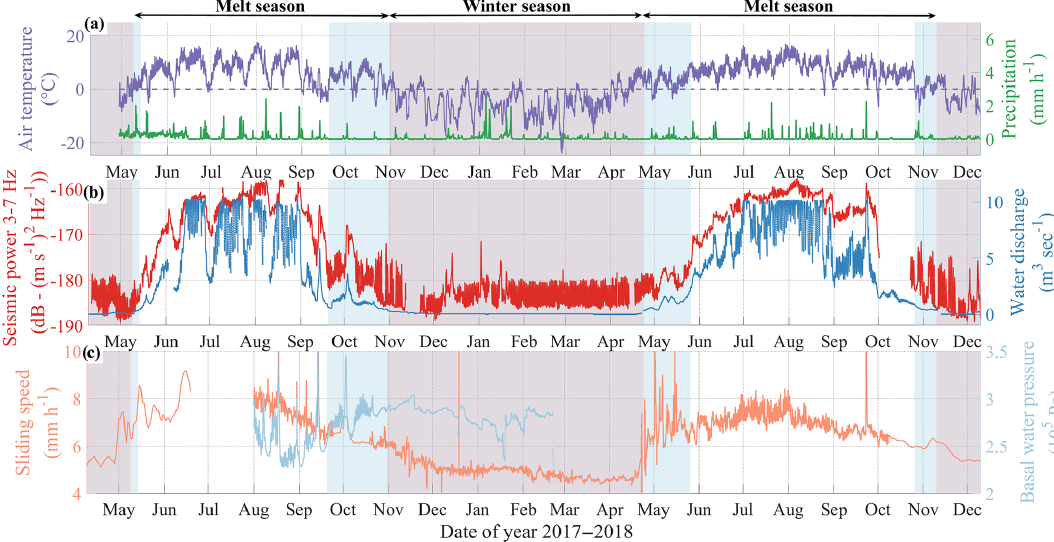
Figure 5. Time series of physical quantities measured from spring 2017 to winter 2018 at Glacier d’Argentière. All data are smoothed over a 6h time window. (a) Surface air temperature (purple line) and precipitation (green line) at the GLACIOCLIM AWS (Fig. 2). The dashed purple line shows T = 0 ◦ C. (b) Averaged seismic power within the 3–7Hz frequency range at the virtual seismic station (red line; P 3–7Hz ; see Sect. 5.2 for details) and subglacial water discharge Q (blue line). (c) Basal sliding speed (orange line) and subglacial water pressure (light blue line) measured at Glacier d’Argentière subglacial observatory (Fig. 2). Note that temporal resolution in the sliding speed is lower in May–July 2017 and from October 2018 on because of instrumental issues. Red shaded areas represent the winter season; blue shaded areas represent the periods when diurnal changes in anthropogenic noise are too pronounced to study P w on a diurnal